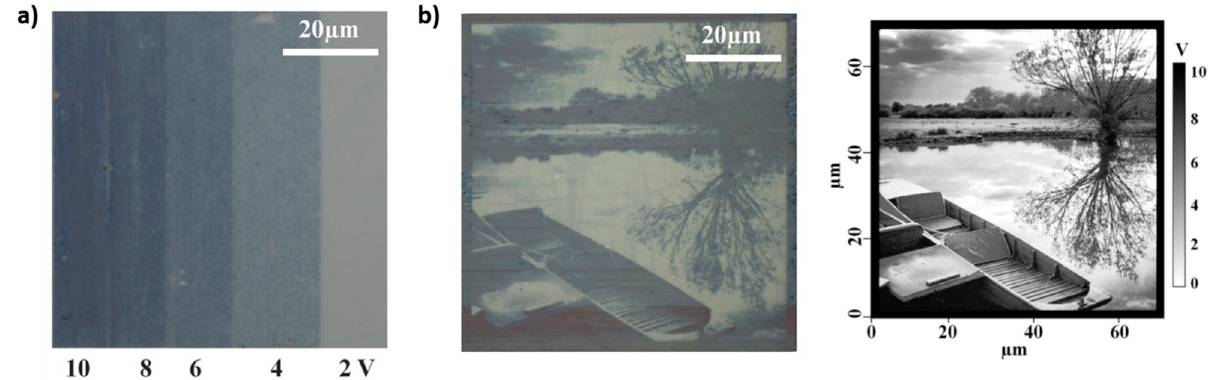
Figure 4. Non-binary grayscale image rendering. ( a ) different colors in reflection mode obtained by scanning voltage varying between 0 and 10 V and inducing different grades of crystallization by means of CAMS; ( b ) reproduction and storage of a greyscale picture of the boat picture shown in the left. The used device is a stacked 10 nm ITO/7 nm AIST/70 nm ITO/Pt sample. Reproduced from Ref. [21] with permission from Wiley.